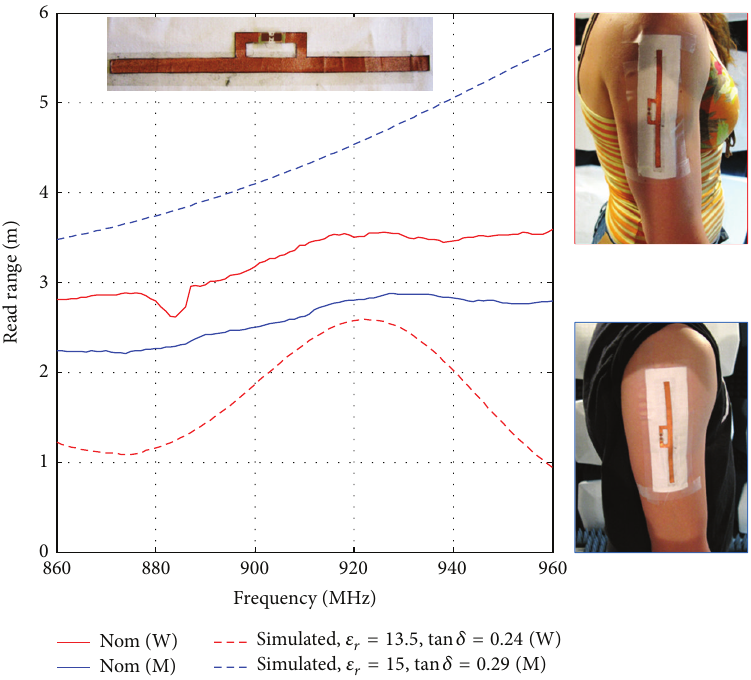
Figure 15: Measured and simulated fabric tag on human arm and human arm model, respectively.